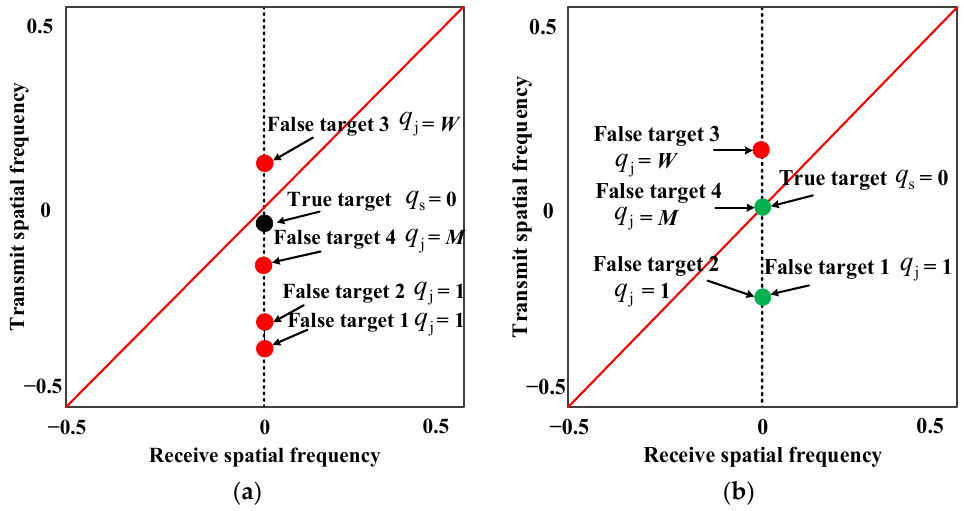
Figure 3. Distribution of the targets in the joint transmit-receive domain. ( a ) Before compensation. ( b ) After compensation.